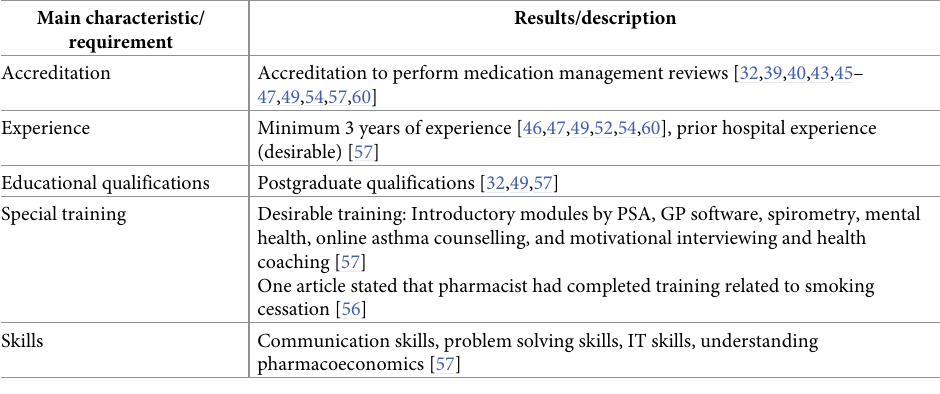
Table 3. Overview of general practice pharmacists’ characteristics described in the